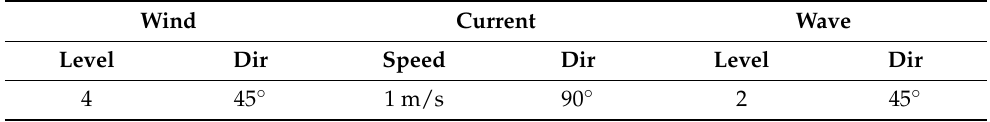
Table 6. Wind, current and wave conditions.